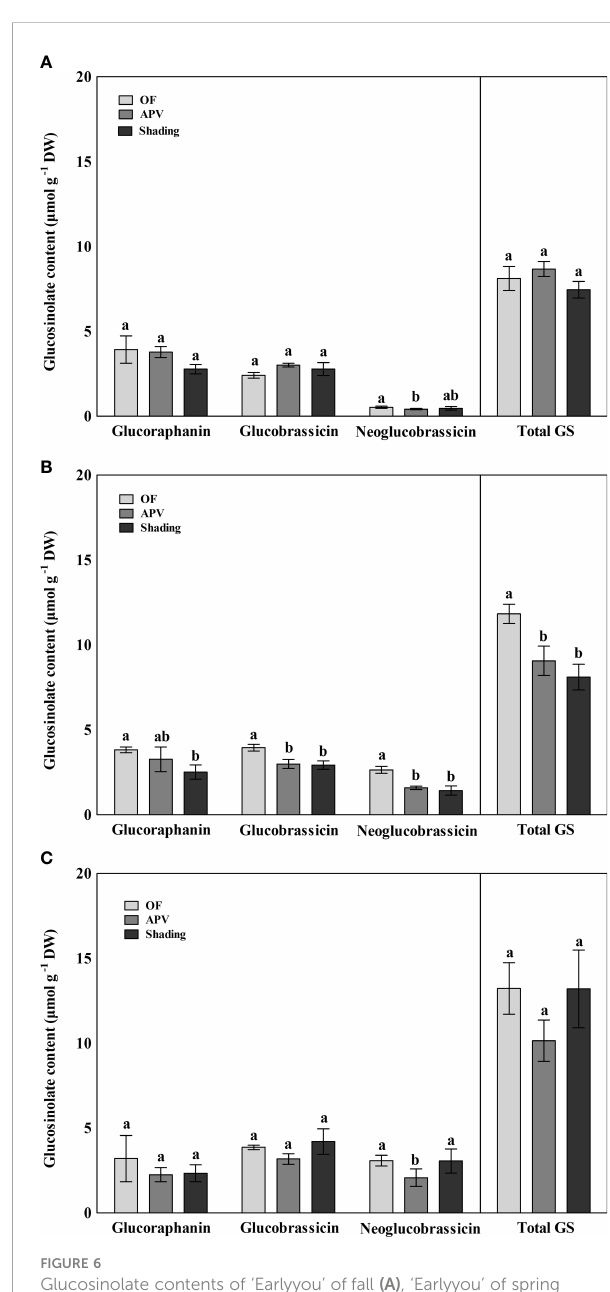
FIGURE 6 Glucosinolate contents of ‘ Earlyyou ’ of fall (A) , ‘ Earlyyou ’ of spring (B) , and ‘ Youil2ho ’ of spring (C) . Lowercase letters indicate signi fi cant differences among treatments within the same cultivar and year by HSD Tukey ’ s test ( p <